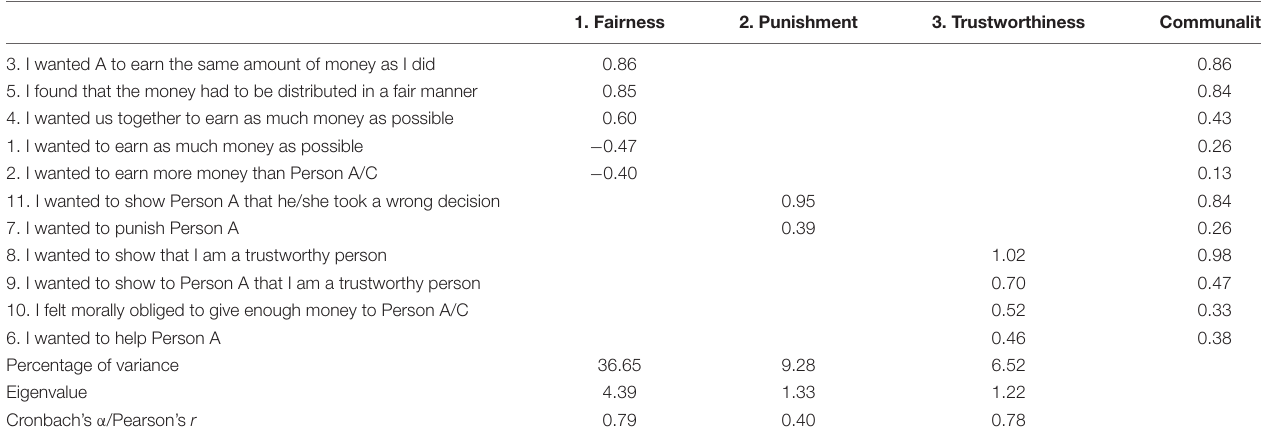
TABLE 8 | Factor loadings based on an exploratory factor analysis with a principal axis factoring and direct oblimin rotation on 11 items measuring B’s main motives in the DG ( N =